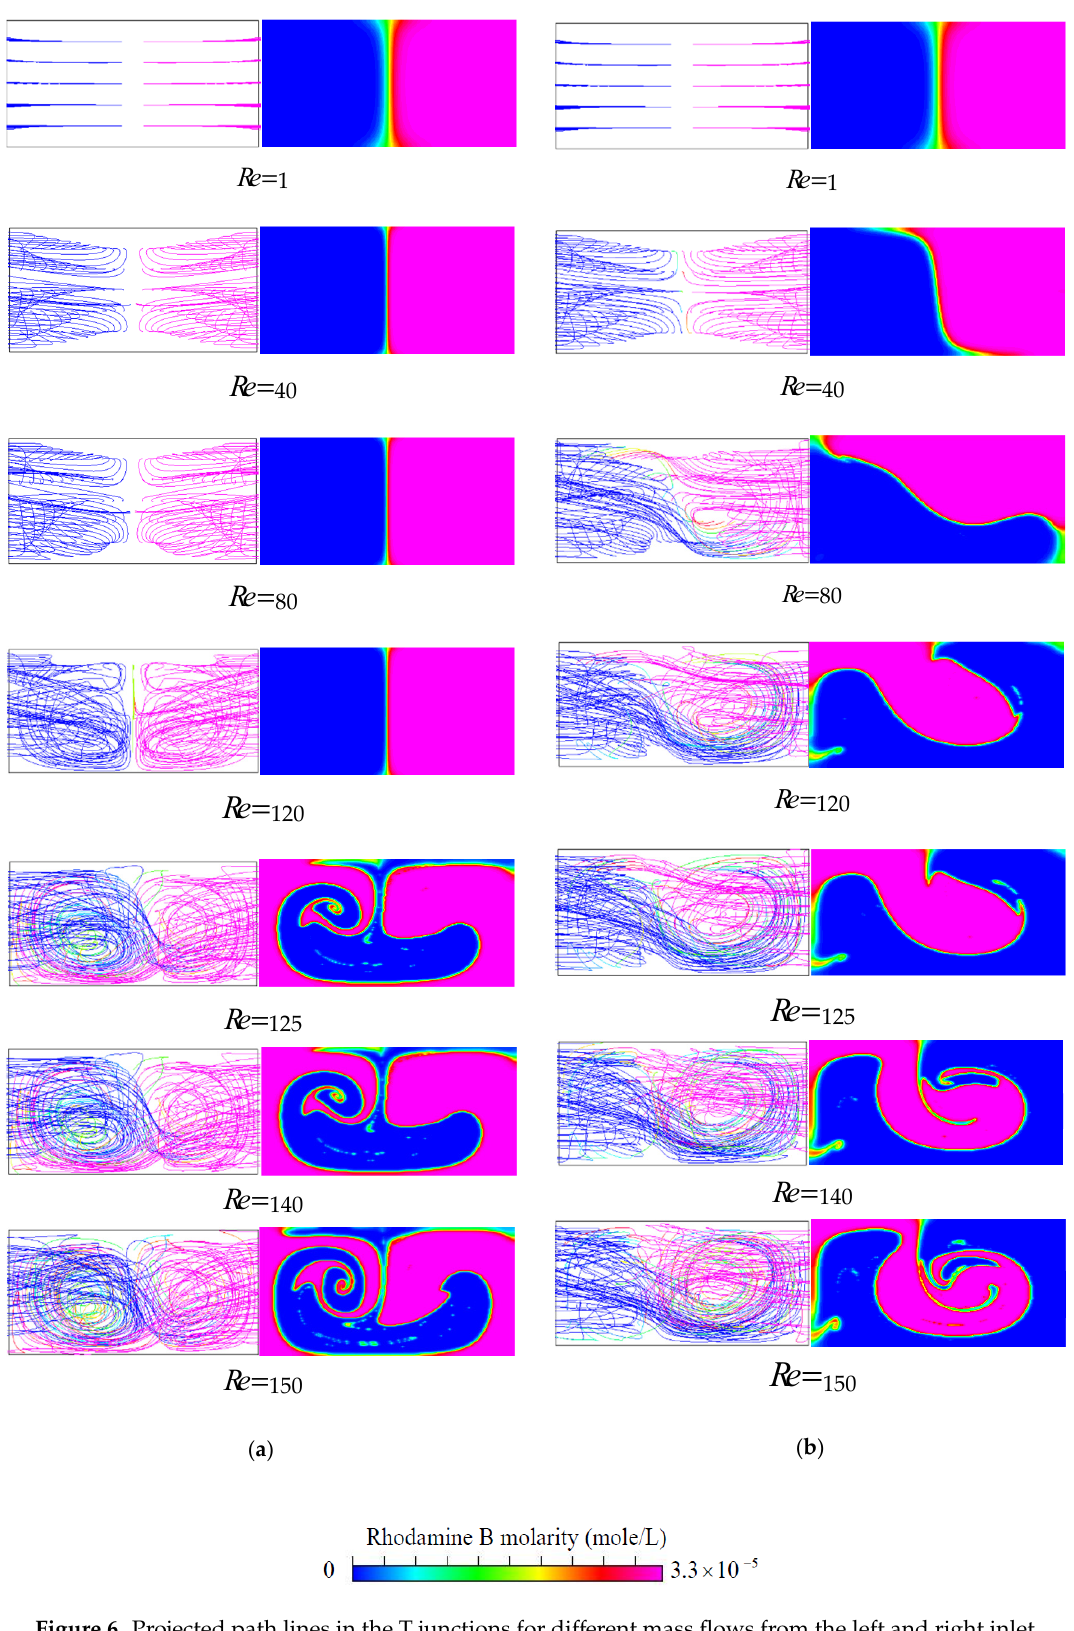
Figure 6. Projected path lines in the T junctions for different mass flows from the left and right inlet channels and the concentration distributions on the cross-section at the exit of ( a ) the mixer with symmetric VIOs and ( b ) the mixer with antisymmetric VIOs. View is into the mixing channel.